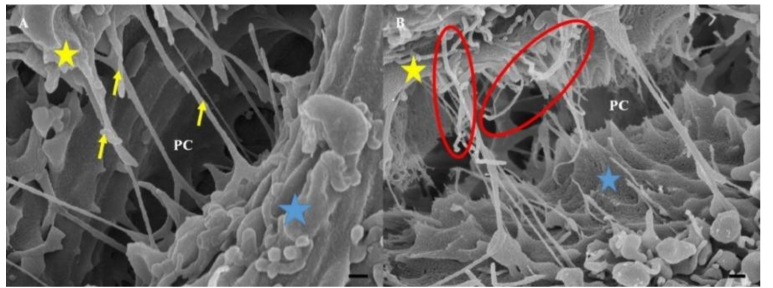
Figure 5. HR-SEM micrographical representation of the morphological deformation of cell-cell connections between adjacent BECs upon Nocodazole-induced cytoarchitectural depolymerization. ( A ) The bEnd5 TENT formation with cells that were grown in standard culture medium. The yellow arrows show the normal nature of PC TENTs, reflecting their bearing and tautness; ( B ) The effect of nocodazole exposure on bEnd5 NT formation relative to the control. The yellow star represents cell 1, the blue star represents cell 2, and the paracellular space is denoted by PC . The red circles in ( B ) indicate NTs which have lost their tautness and demonstrate the recoiling of TENTs in the Nocodazole-treated bEnd5 cell